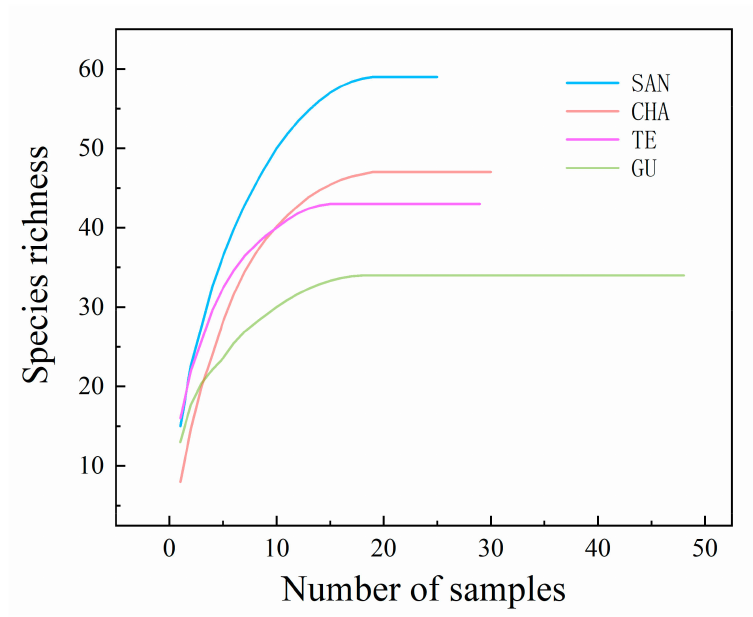
Figure 2. The rarefaction curve of four sampled meadows.